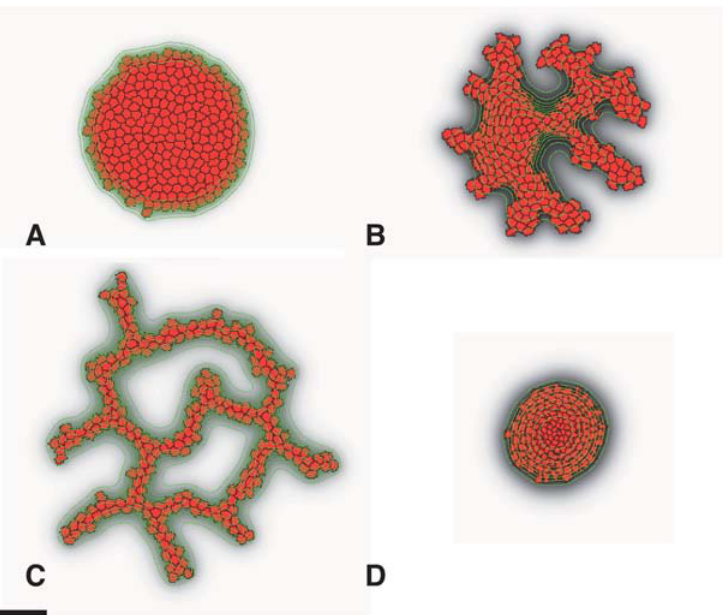
Figure 4. Sprouting instability in a simulation initiated with a cluster of endothelial cells. (A) After 10 MCS (5 min). (B) After 1,000 MCS ( , 8 h). (C) After 10,000 MCS ( , 80 h). (D) No sprouting in a simulation without contact inhibition of chemotaxis ( x ( c , c )/ x ( c , M )=1) at 10,000 MCS ( , 80 h). Scale bar: 50 lattice sites ( < 100 m m).